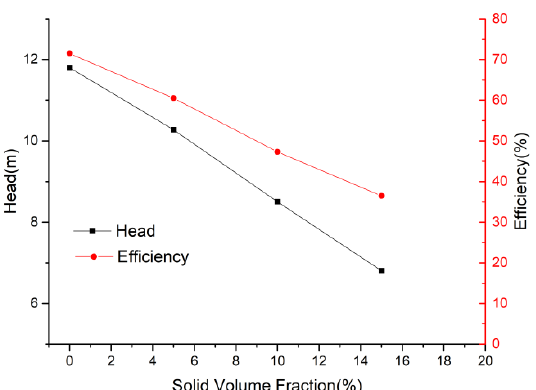
Figure 18. Pump performance characteristics curve under different solid phase volume fractions ( Q = 1.0 Q BEP , d p = 0.6 mm).